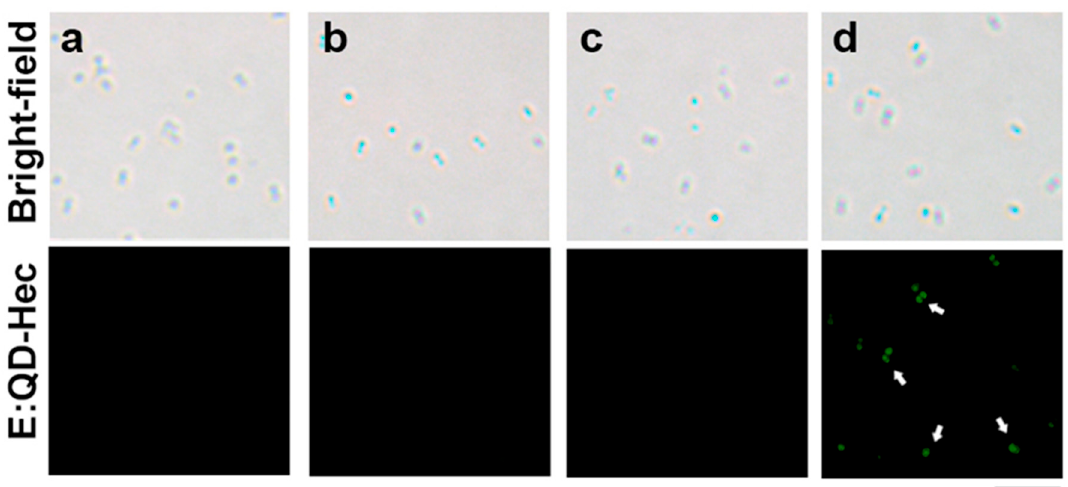
Figure 6. ( a ) Optical and fluorescence images of control VRSA where the bacteria were incubated in LB without any E:QD or Hec; ( b ) optical and fluorescence images of VRSA incubated only with Hec; ( c ) optical and fluorescence images of VRSA incubated only with E:QDs, with the fluorescence field; ( d ) optical and fluorescence images of VRSA incubated with E:QD-Hec conjugate with the fluorescence field. The scale bar is 5 µm.